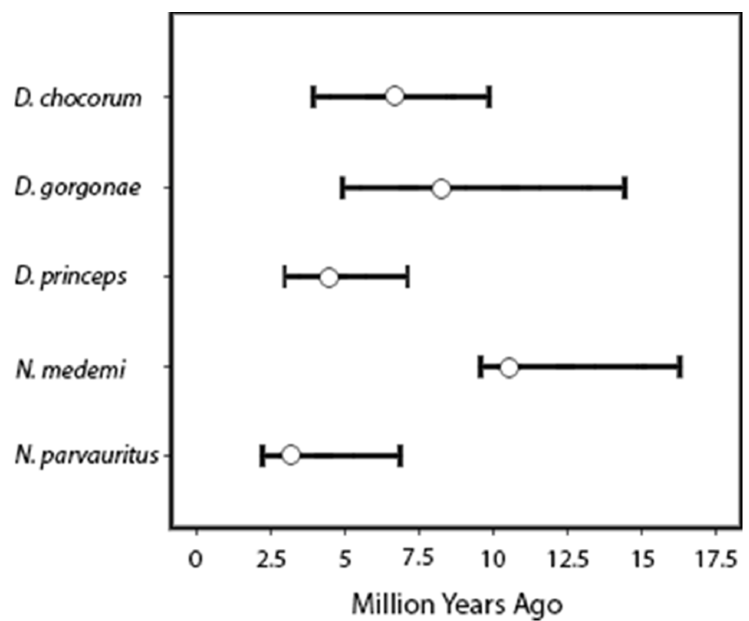
Figure 5. Range of divergence dates (95% CI) for each of the five anole lineages on Isla Gorgona from a mainland ancestor. Mean node age is represented by an open circle.